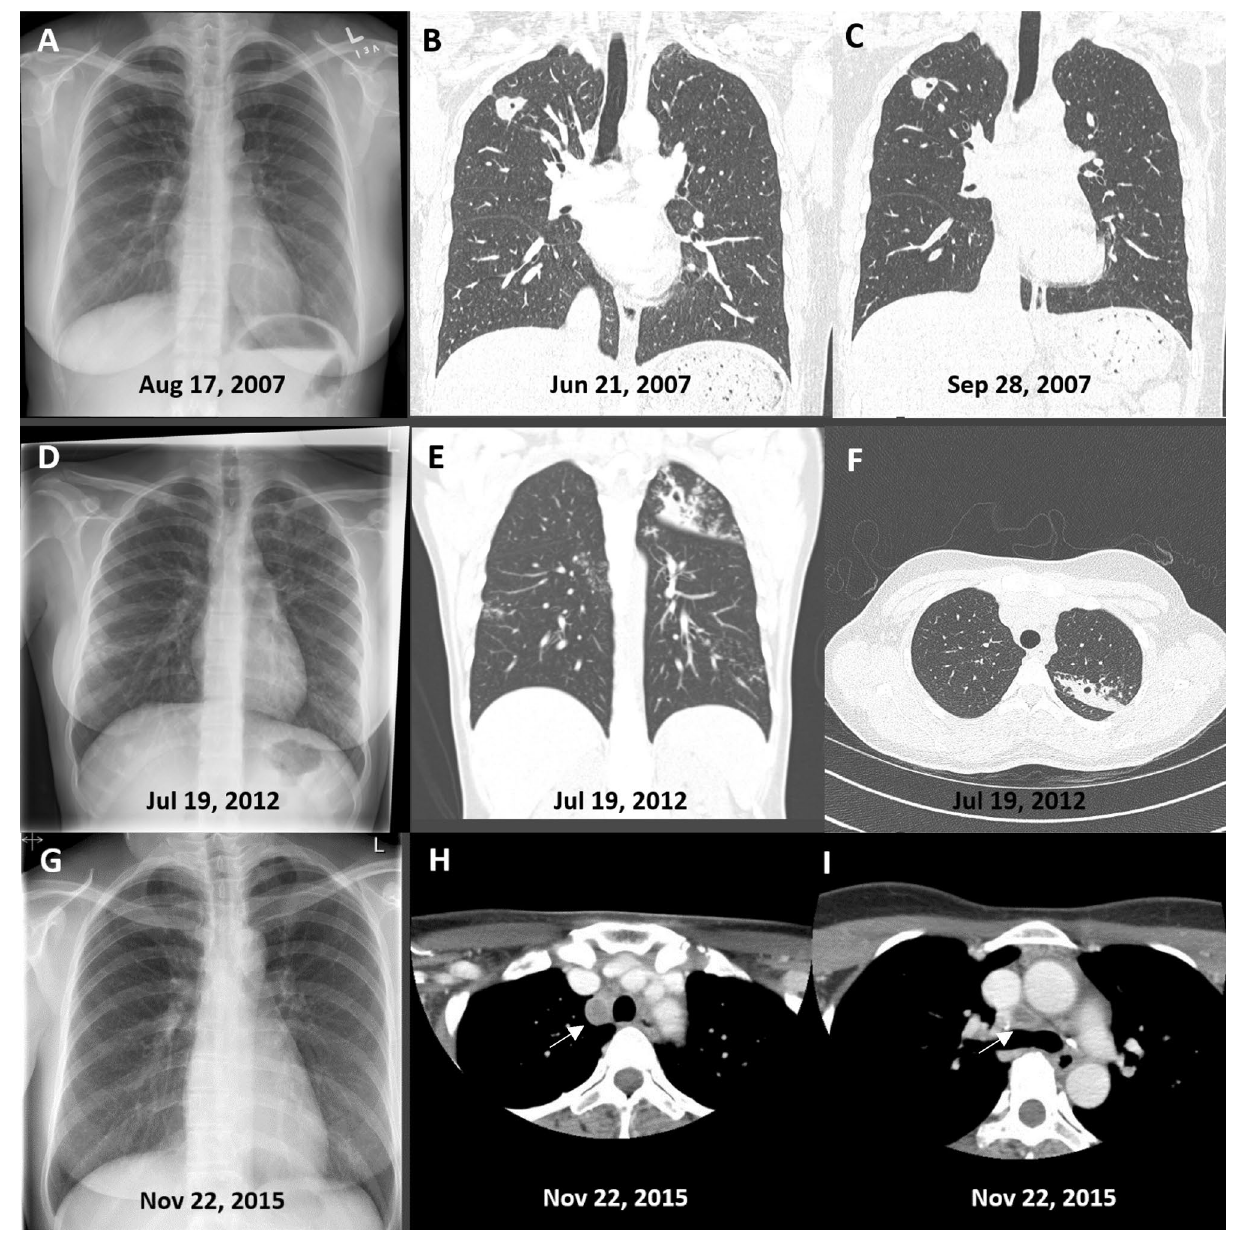
Figure 2. ( A,B,C ) Frontal chest radiograph ( A ) and thin Sect. (1.0 mm) coronal reformat computed tomographic (CT) images ( B and C ) in a patient diagnosed with smear-negative, culture-positive subclinical pulmonary tuberculosis on August 28, 2007. A small cavity is visible on CT scan but not on chest radiograph; the abnormality in the right upper lobe is stable over several months. ( D,E,F ) Frontal chest radiograph ( D ), a multiplanar reformation (MPR) coronal CT image (3 mm) ( E ) and a 1 mm transverse CT image through the upper thorax ( F ) in a patient diagnosed with smear-negative, culture-positive subclinical pulmonary tuberculosis on July 26, 2012. Cavitation is visible on CT scan but not on chest radiograph; endobronchial spread is more visible on CT scan than on chest radiograph. ( G,H,I ) Frontal chest radiograph ( G ) and 3 mm transverse CT images at the level of the aortic arch ( H ) and main carina ( I ) in a patient diagnosed with smear- positive, culture-positive subclinical pulmonary tuberculosis on November 24, 2015. An enlarged, centrally necrotic, lymph node is visible in the right paratracheal area ( H ) and a borderline enlarged centrally necrotic lymph node is visible just anterior to the main carina ( I ) on CT scan; neither was clearly visible or reported on chest